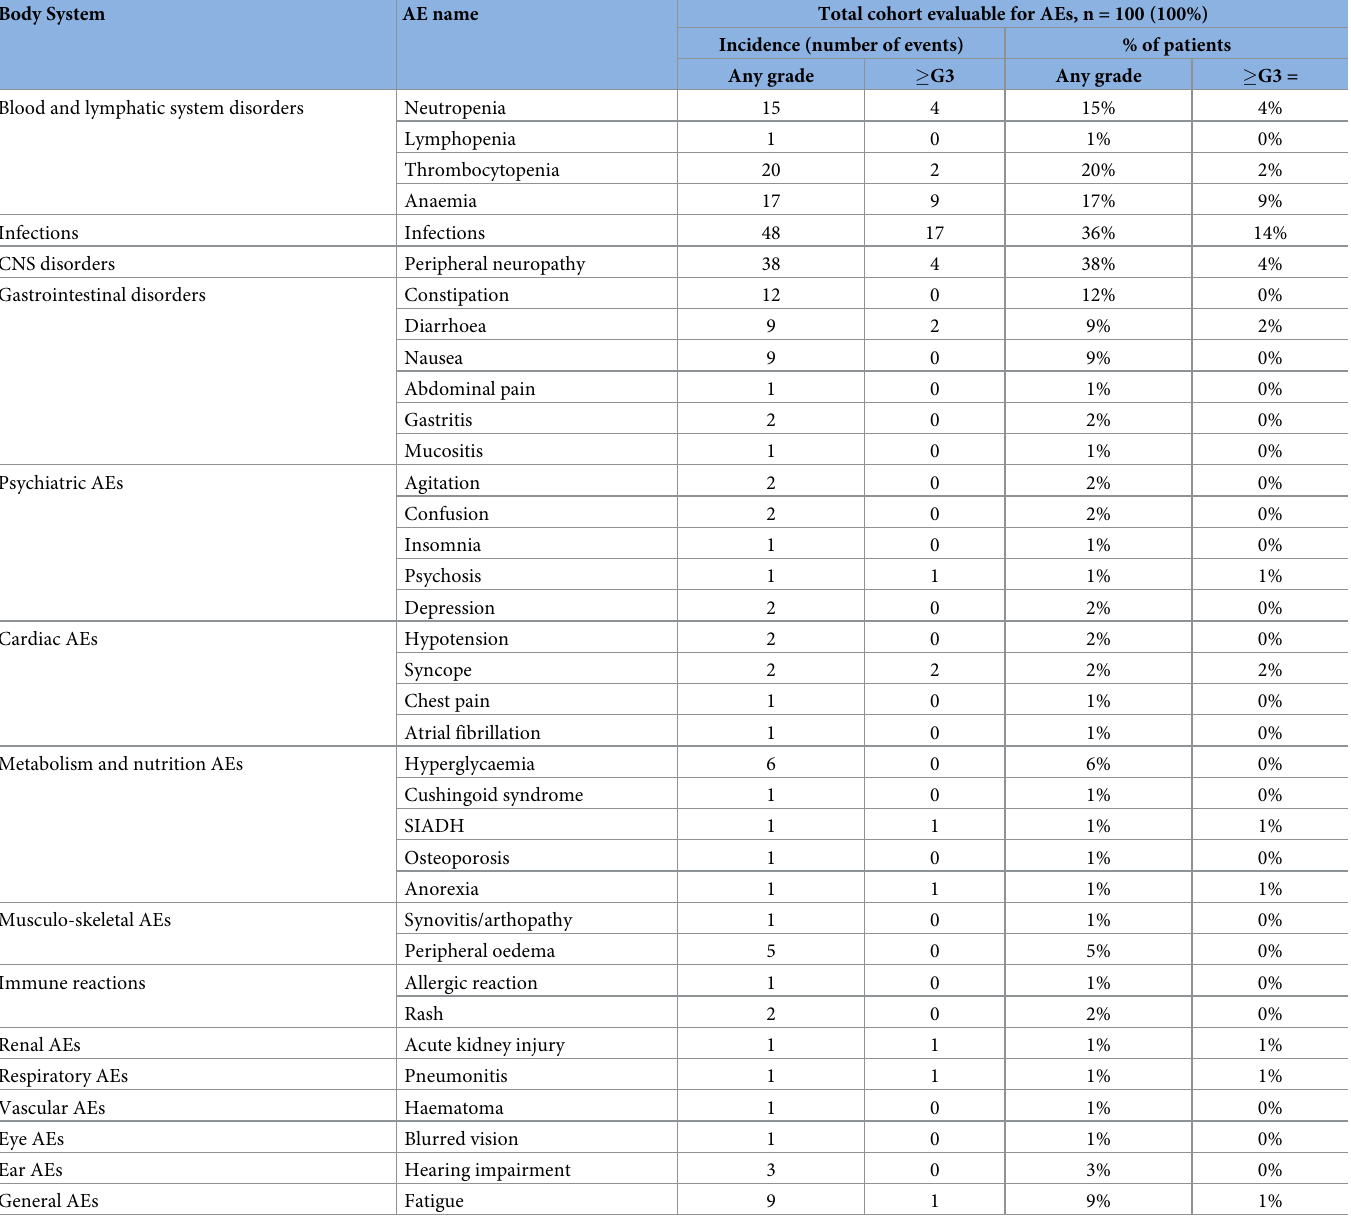
Table 5. Toxicities associated with VCD therapy in the total